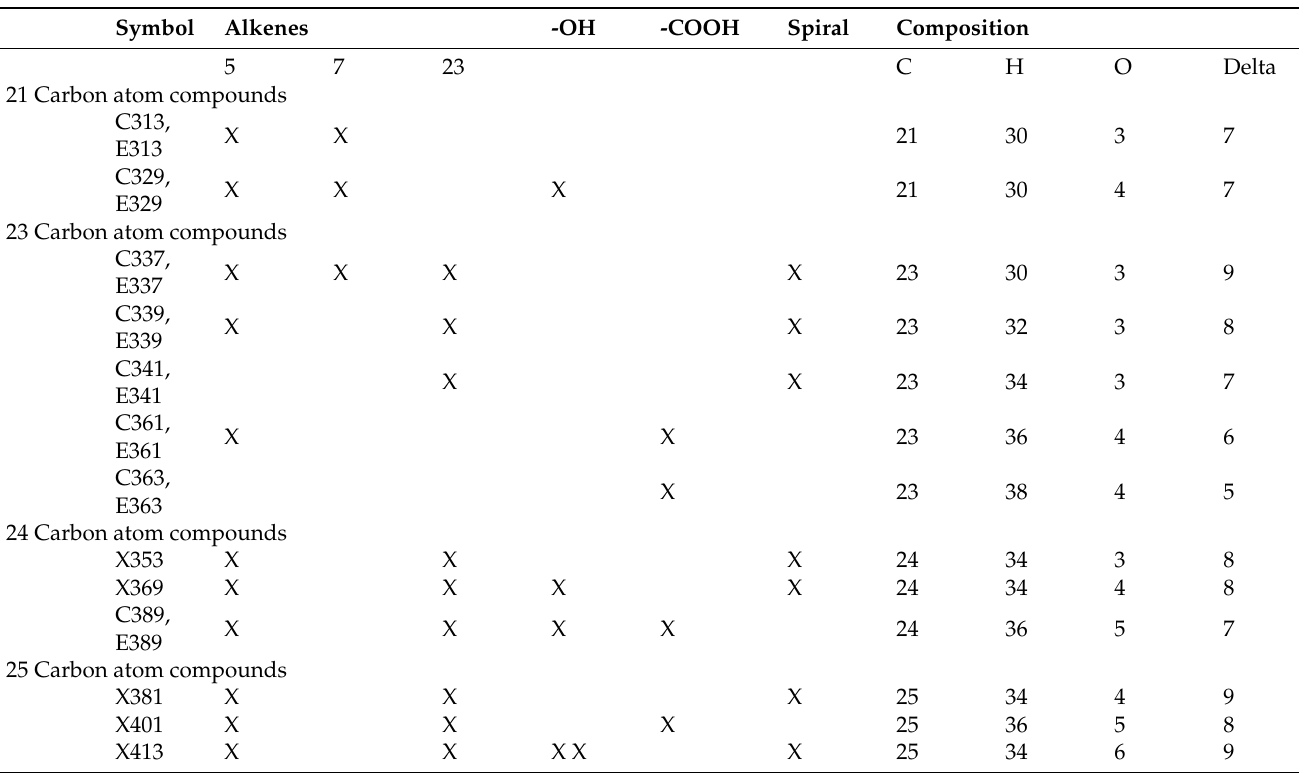
Table 2. Structural components of newly discovered steroids.